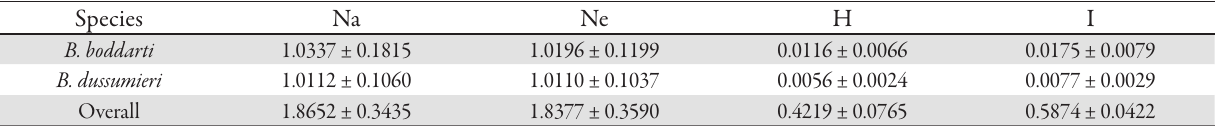
Tab. 2. Overall observed number of alleles (Na), Effective number of alleles (Ne), Nei’s (1973) gene diversity (H), Shannon’s